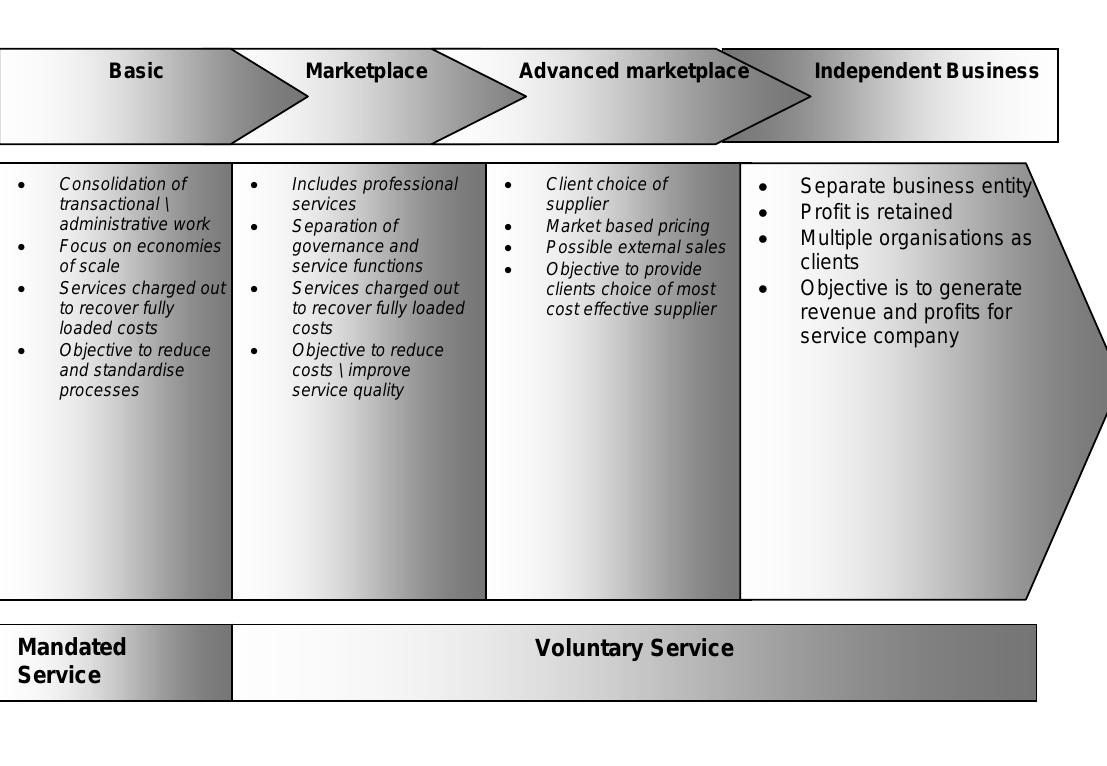
Figure 6: Future Development Of Shared